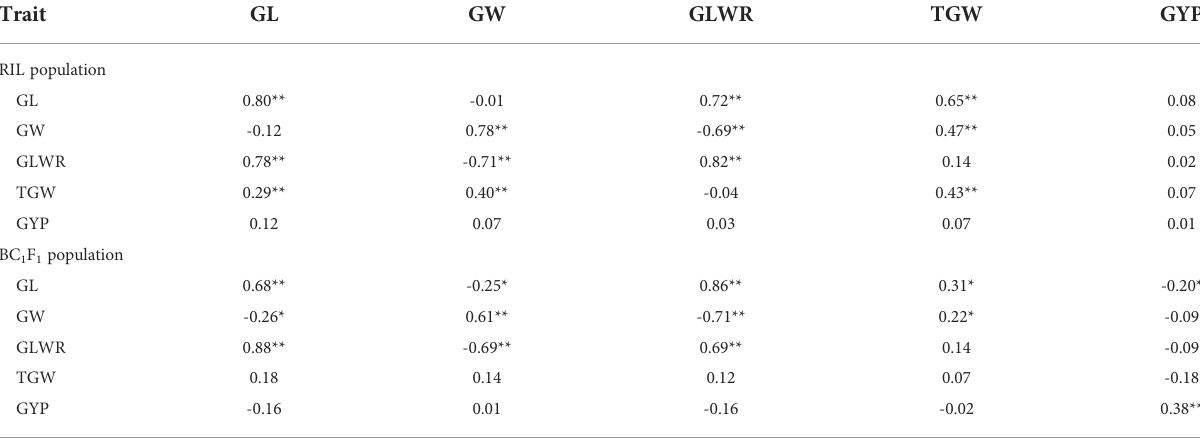
TABLE 2 Correlations between grain shape and grain weight as well as grain yield traits estimated in RIL population and BC 1 F 1 (Q9311A × RILs) population in Hefei (upper triangular) and Nanning (lower triangular).